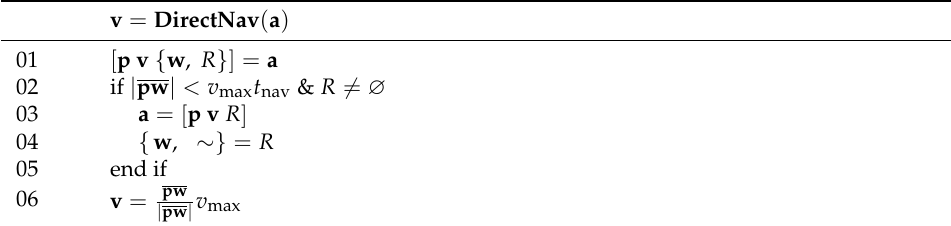
Figure 2. Two UAVs in the airspace. Table 1. Direct navigation to the